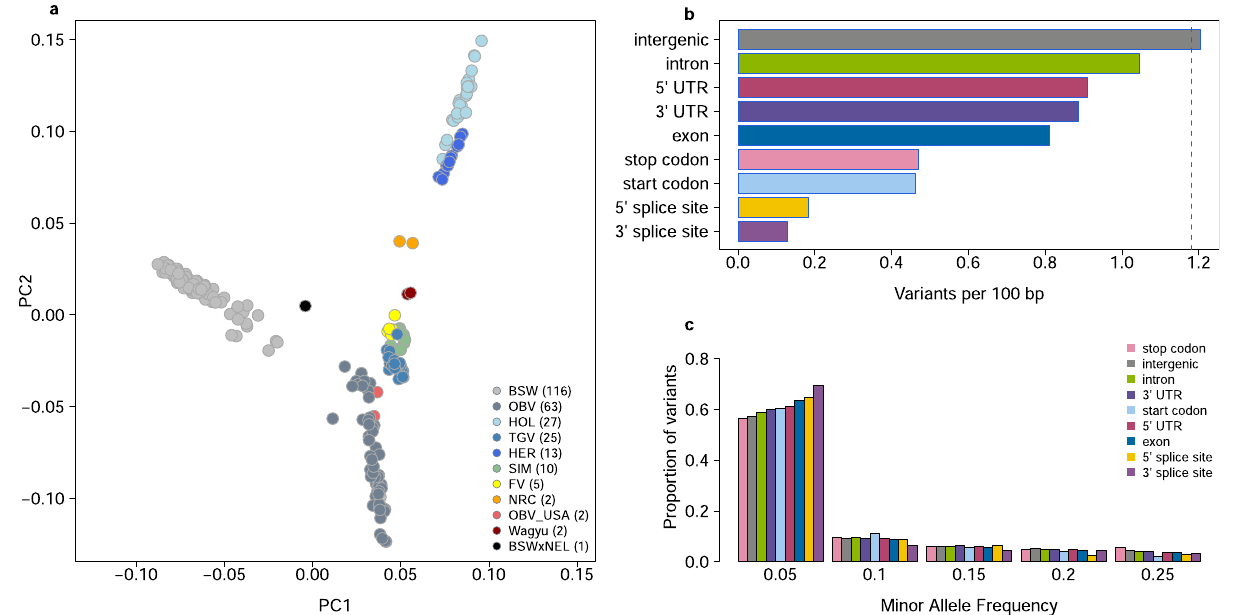
Fig. 1 Constraints on well-annotated features uncovered from a large bovine variant catalogue. Plot of the fi rst two principal components (PC) of genomic relationship matrix among 266 cattle used to establish the variant catalogue. Individuals are colored according to breeds (BSW Brown Swiss, OBV Original Braunvieh, HOL Holstein, TGV Tyrolean Grey, HER Hereford, SIM Simmental, FV Fleckvieh, NRC Norwegian Red Cattle, NEL Nellore). Values in parentheses indicate the number of samples per breed ( a ). Variation ( b ) and allele frequency spectrum ( c ) within nine annotated genomic features. Variation is expressed as the number of variable nucleotides per 100 bp of the feature. The blue dotted line indicates the average genome-wide variation.